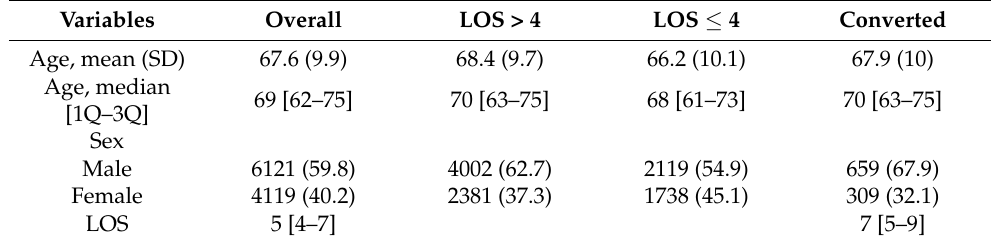
Table 1. Patients’ preoperative characteristics.